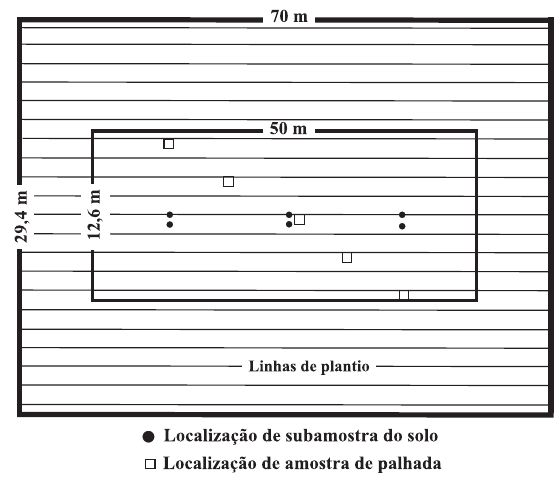
Figura 1. Representação da parcela de amostragem e localização das subamostras de solo e amostras de palhada. As linhas horizontais representam as linhas de plantio de